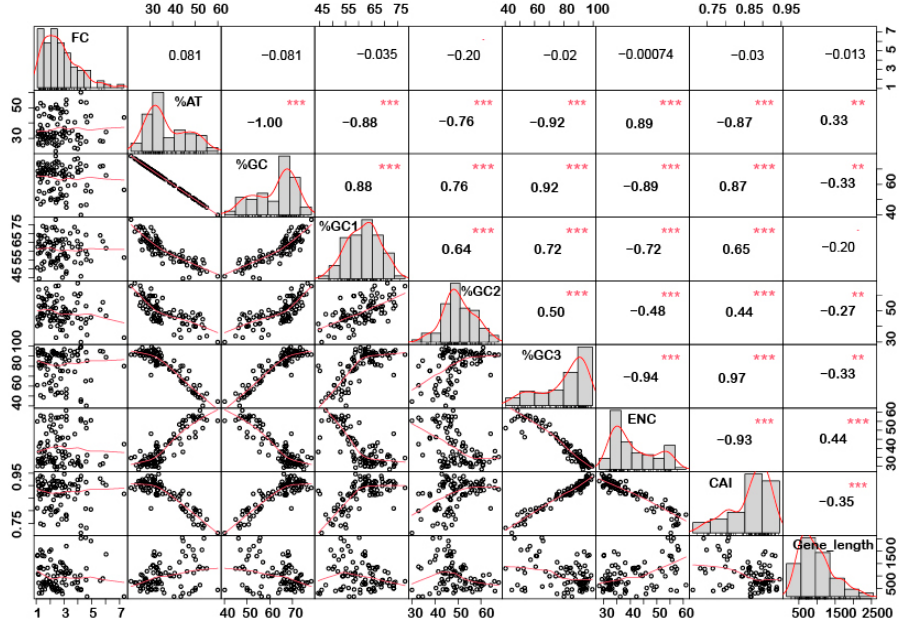
Figure 2. Correlation analysis among nucleotide composition, gene expression, gene length, ENC, and CAI of upregulated genes under abiotic stress. Based on the %GC, genes were grouped into two different categories, i.e., high and low %GC groups. %GC1 was positively correlated with gene expression, while %GC content (at the first, second and third codon positions) was negatively correlated with ENC and gene length while positively correlated with CAI. Asterisk indicate significant correlation, as *** with a p -value < 0.001, and ** with p -value < 0.05. FC = fold change; ENC = effective number of codons; CAI = codon adaptation index.